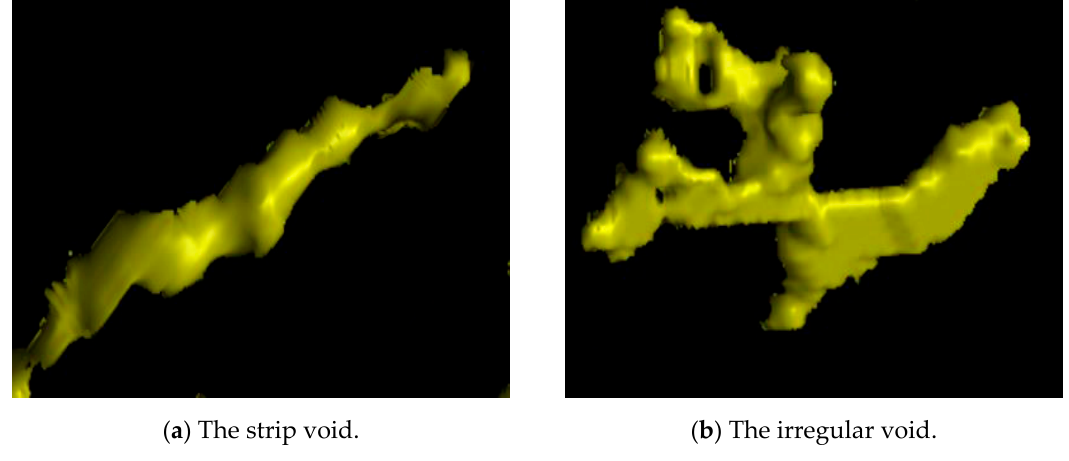
Figure 6. The schematic diagram of the strip void and irregular void.